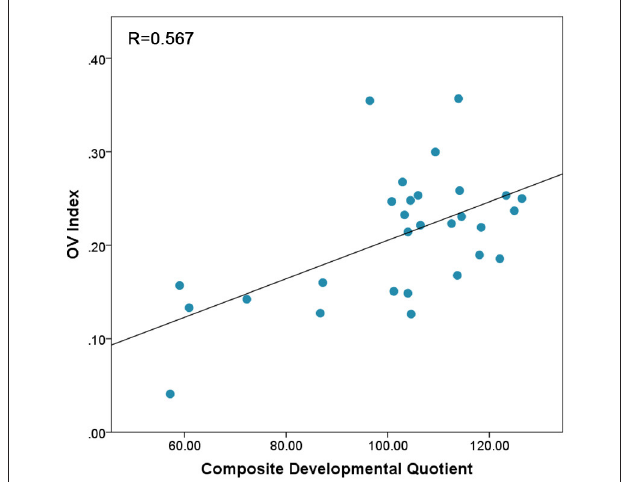
FIGURE 2 | Correlation between OV index values combined across Left and Right prefrontal cortex and Composite-DQ across all toddlers exhibiting trend of higher OV index in toddlers with higher